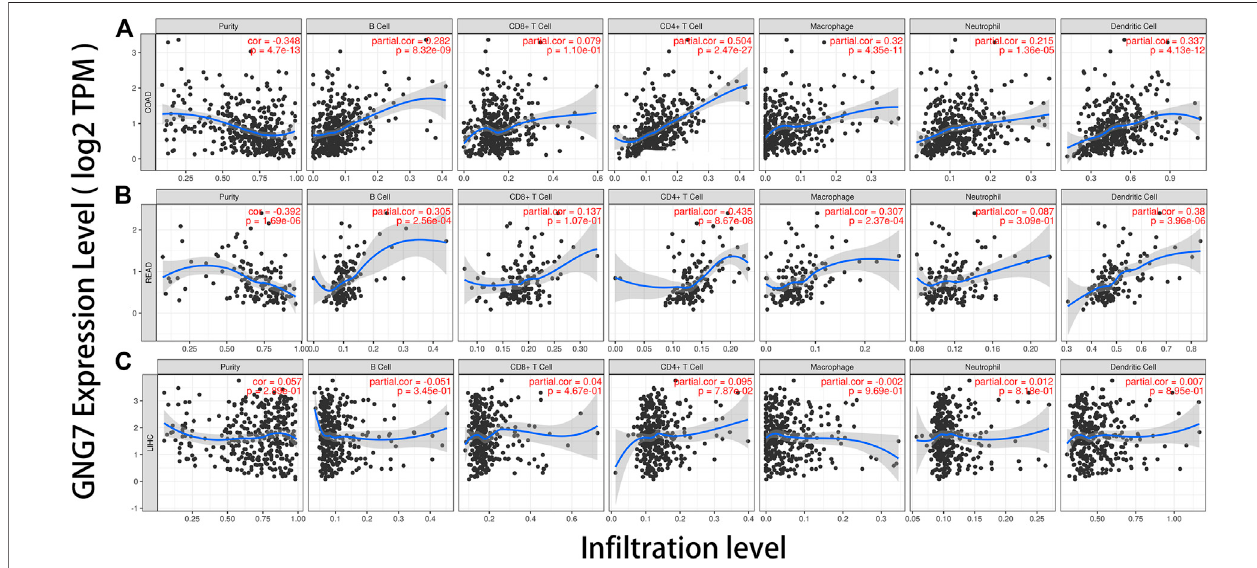
FIGURE 7 | Correlation of GNG7 expression with immune in fi ltration level in COAD (colon adenocarcinoma), READ (rectum adenocarcinoma), and LIHC (liver hepatocellular carcinoma). (A) GNG7 expression is signi fi cantly negatively related to tumor purity and has signi fi cant positive correlations with in fi ltrating levels of B cells, CD4 + Tcells,macrophages,neutrophils, anddendriticcellsinCOAD,otherthanCD8 + Tcells. (B) GNG7expressionissigni fi cantlynegatively related totumorpurityand has signi fi cant positive correlations with in fi ltrating levels of B cells, CD4 + T cells, macrophages, and dendritic cells in READ but no signi fi cant correlation with in fi ltrating level ofCD8 + T cells and neutrophils. (C) GNG7expression has no signi fi cant correlations with tumor purity and in fi ltrating levels ofB cells, CD8 + T cells, CD4 + T cells, macrophages, neutrophils, and dendritic cells in LIHC.